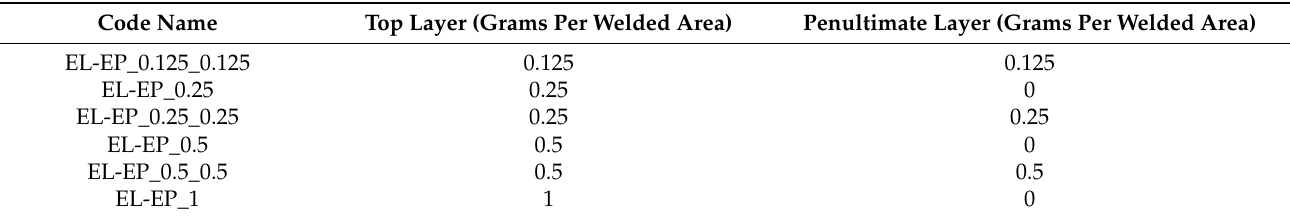
Table 1. Location and mass of sprinkled polymethyl methacrylate (PMMA)